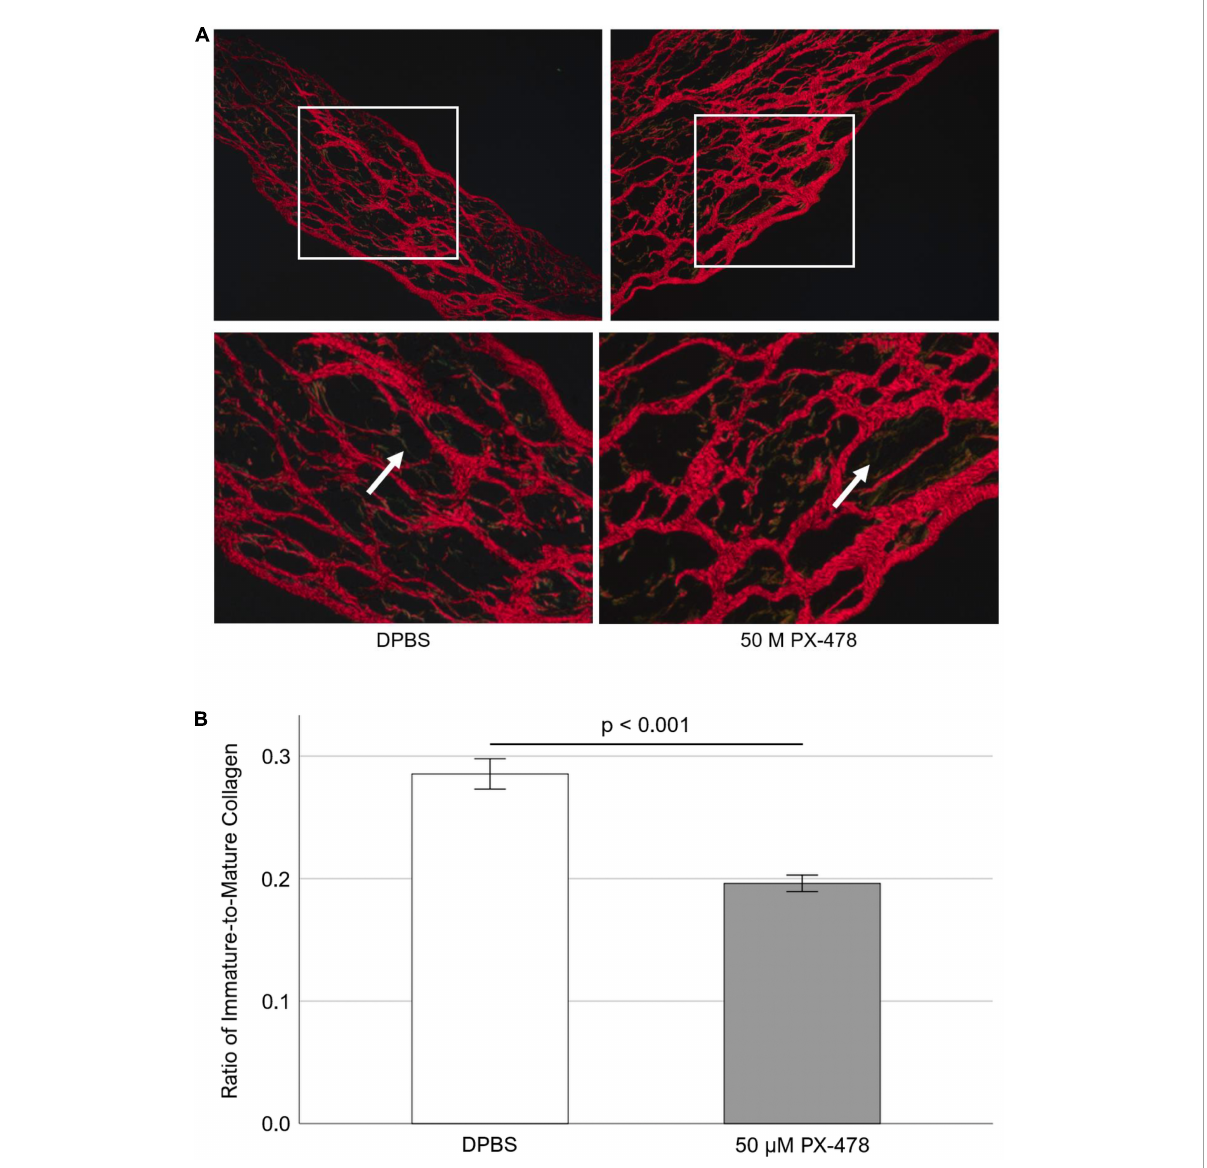
FIGURE4 (A) Representative Picrosirius Red staining images of porcine aortic valve (PAV) leaflets after 24 days of 15% stretch in osteogenic medium. Red fibers indicate mature collagen; green and yellow fibers indicate immature collagen (white arrows). (B) Quantification of Picrosirius Red staining images of PAV leaflets after 24 days of 15% stretch in osteogenic medium ( n = 7). Each sample comprises of multiple images representing multiple locations (minimum 5 images per